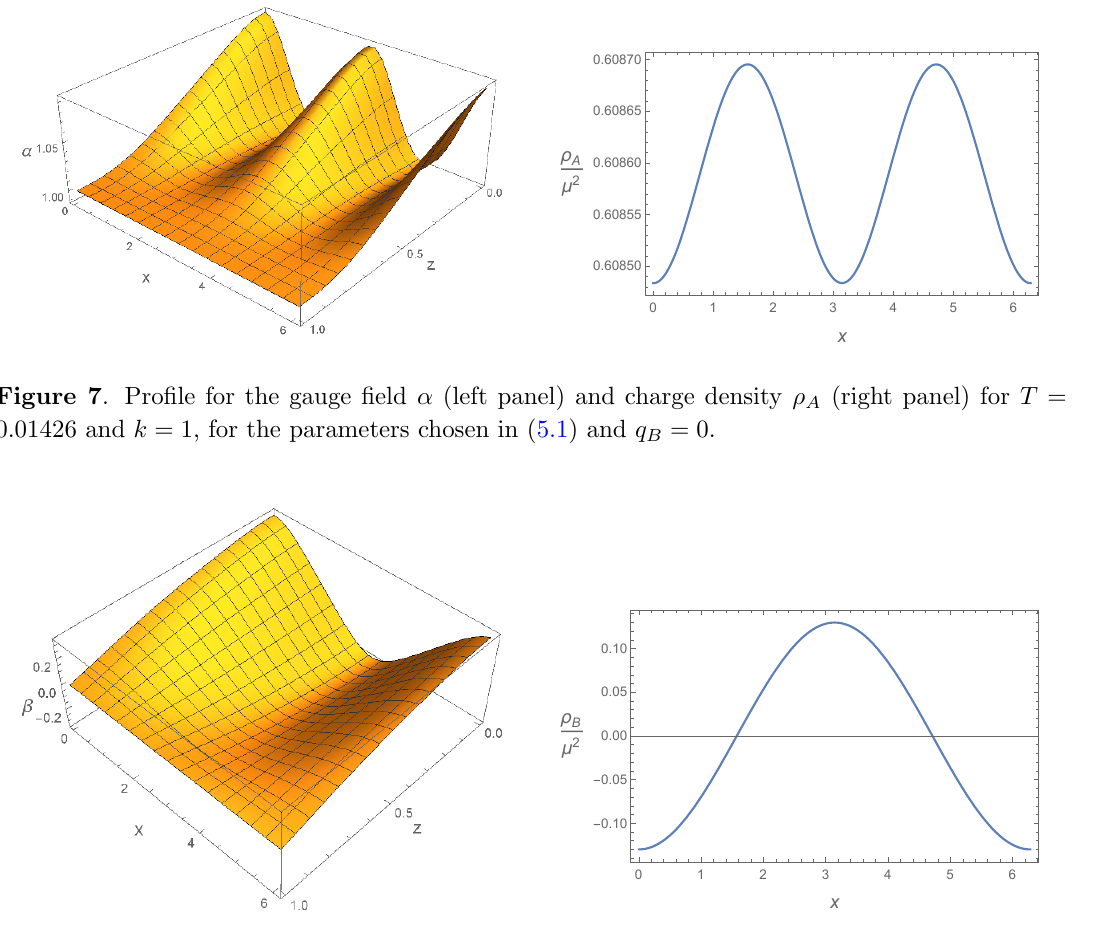
Figure 8 . Pro(cid:12)le for the gauge (cid:12)eld (cid:12) (left panel) and charge density (cid:26) B (right panel) for T = 0 : 01426 and k = 1, for the parameters chosen in (5.1) and q B = 0. Note that the average of (cid:26) B is zero.